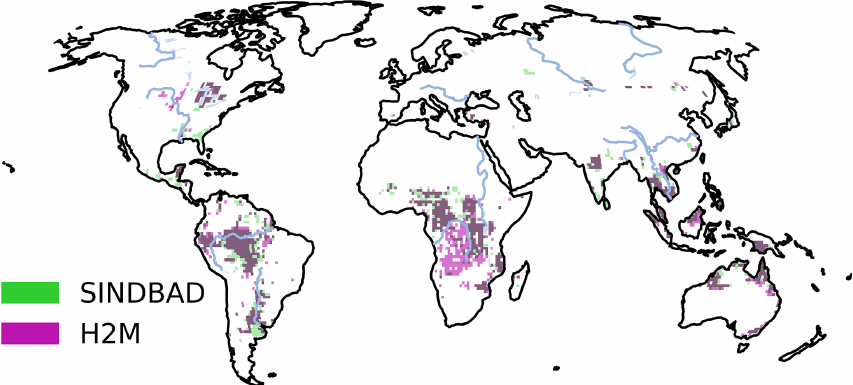
Figure B7. Spatial patterns of error hotspots of modeling errors in terrestrial water storage (TWS) interannual variability (IAV). Error hotspots mean pixels with 10% of the largest positive contributions to the global TWS IAV modeling errors (Fig. 4). Red pixels are error hotspots identified using SINDBAD, light purple pixels are error hotspots identified using H2M, and dark purple pixels are commonly identified error hotspots by the two models.